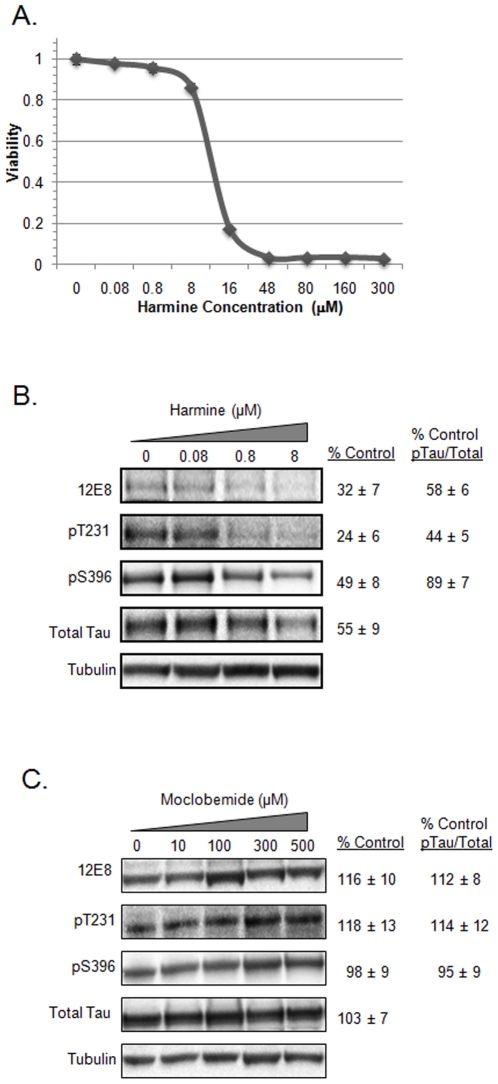
Harmine, a DYRK1A antagonist, inhibits tau phosphorylation.Shown in (A) is the toxicity profile of harmine against the H4 neuroglioma cell line. The IC50 for viability was 12 µM. In (B), are results of a dose-response treatment of H4-tau cells with harmine at the indicated concentrations. Reductions to total tau and all three phosphorylated forms of tau tested were observed. % control values represent the amount of the respective tau forms present following treatment with 8 µM harmine, although 0.8 µM harmine also reduced phospho-tau levels significantly. Harmine treatment was performed as described in the Methods. For (C), results for moclobemide, an MAO-A selective antagonist, are shown. % control values represent the amount of each form of tau present following treatment with the highest 500 µM concentration.